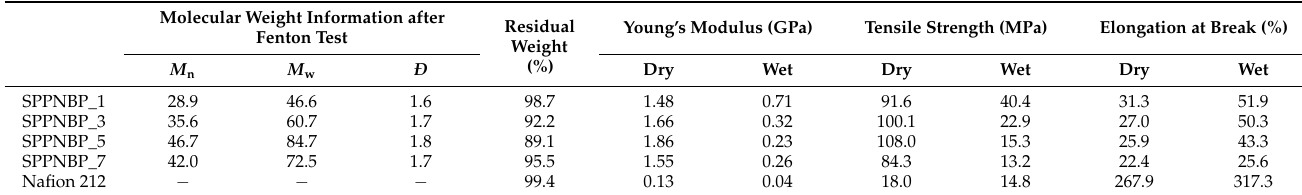
Figure 5. ( a ) GPC profiles of SPPNBP series before (solid lines) and after Fenton test (dotted lines). ( b ) 1 H-NMR spectra of SPPNBP membranes after the Fenton test. Table 2. The Fenton test results, and the mechanical properties of SPPNBP membranes.